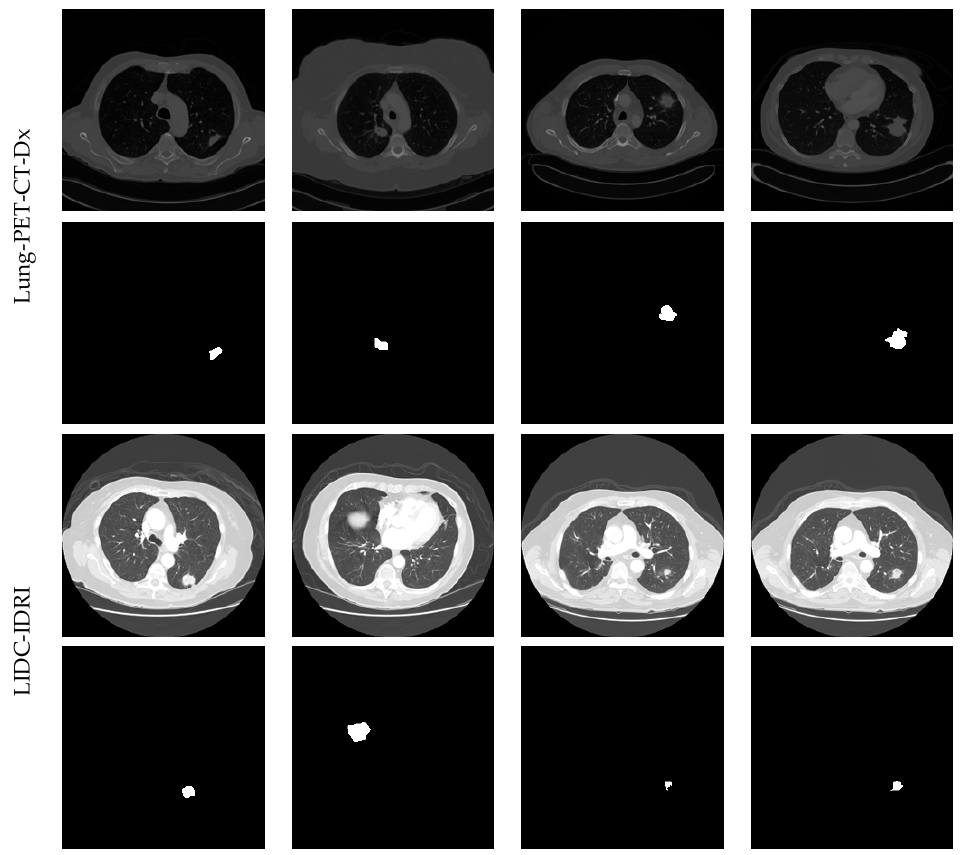
Figure 6. Segmentation of nodule from chosen images of Lung-PET-CT-Dx and LIDC-IDRI dataset. After collecting the essential DF with VGG19, the other HCFs, such as GLCM, LBP and PHOG are collected. The GLCM features for the normal (healthy) class image are collected from the whole CT image, and for the abnormal class image it is collected from the binary image of the extracted nodule segment. Figure 7 shows the LBP patterns gen- erated for the normal/nodule class test images with various weight values. During LBP feature collection, each image is treated with the LBP algorithm with various weights (ie, W = 1 to 4) and the 1D features obtained from each image are combined to obtain a 1D feature vector of dimension 1 × 236 .